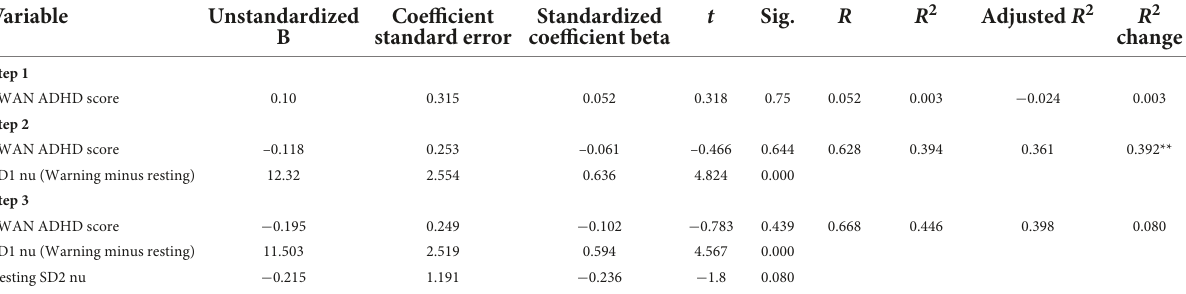
TABLE 6 Regression model of the ANS measures as the predictors of the CCPT commissions in the SCT group.